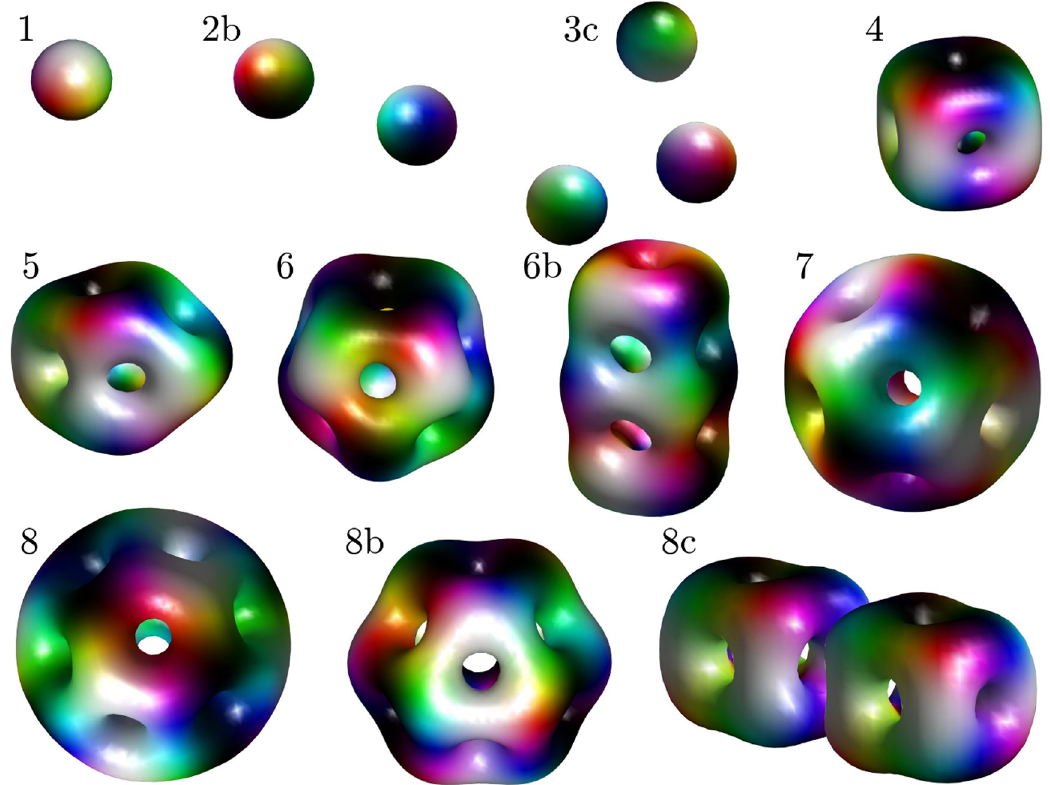
Figure 7 . Numerical solutions for baryon numbers B = 1 through B = 8. The B = 2 ; 3 ; 8c solutions are delocalised but bound states. The labels are kept the same as used in section 4. The stable solutions appear (cid:12)rst (left-most) and the metastable solutions have increasing energy in order of appearance.